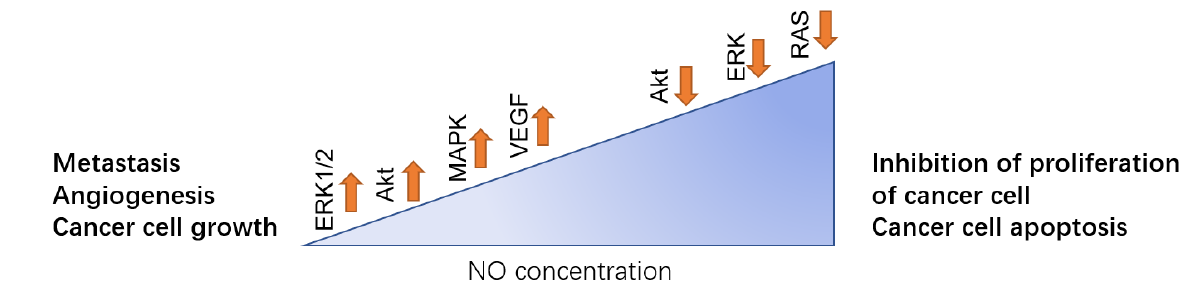
Figure 2. In breast cancer, different NO concentration levels play the opposite role. Low level of NO can facilitate the metastasis to other site of body such as lung, angiogenesis of the tumor and promote the cancer cell growth, which is mainly regulated by activation of ERK1/2, Akt, MAPK, and VEGF. While in high concentration, NO can downregulate those pathways, thus inhibiting the proliferation of the cancer cell and inducing cell apoptosis.